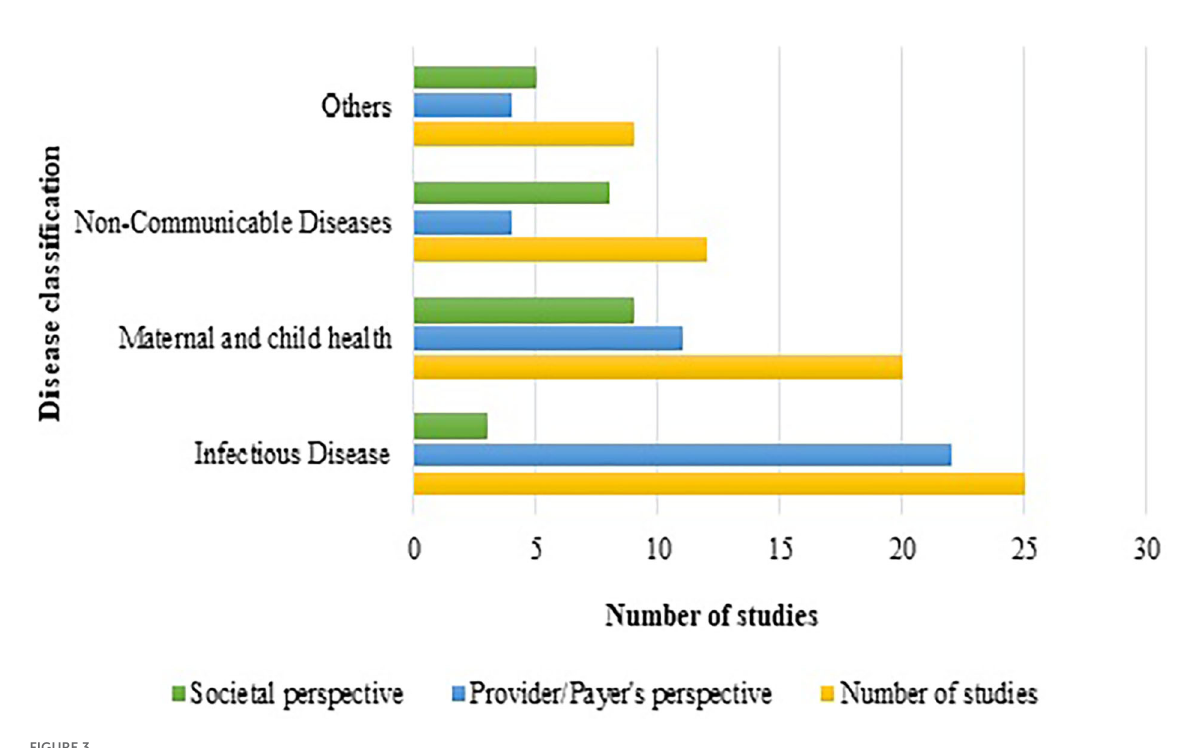
FIGURE3 Number of HTA studies classified as per disease and perspective.